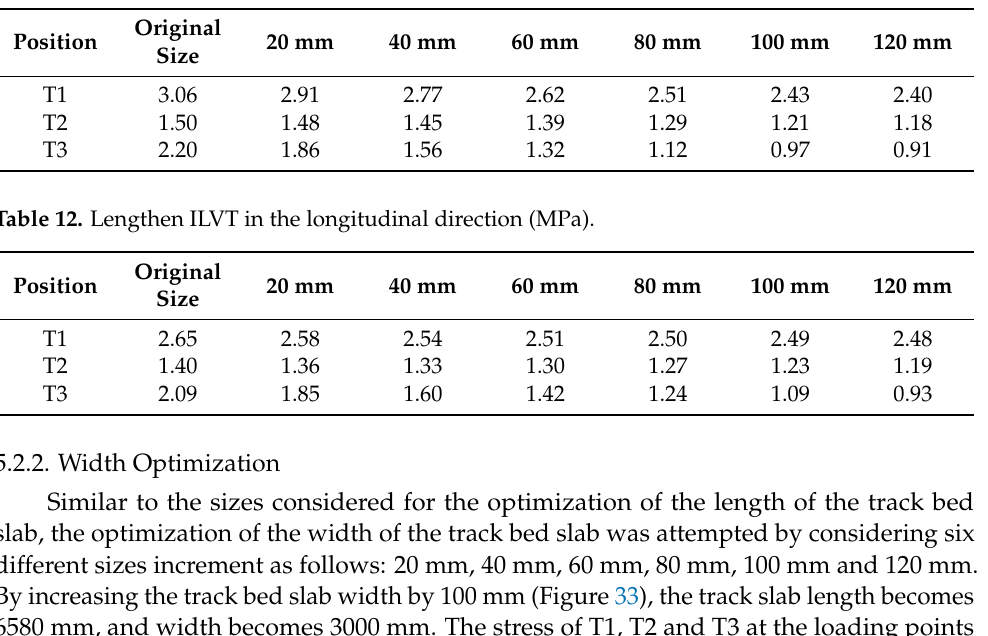
Table 11. Lengthen TLVT in the longitudinal direction (MPa).